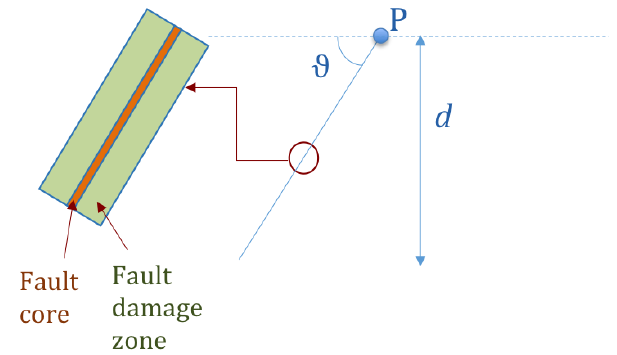
Figure 1. Geometry of a fault. Fault extends from a shallow point P , over a vertical distance d and forms a dip-angle θ with the hori- zontal axis. The fault structure comprises two units: a central narrow core zone surrounded by a wider damage zone. Both units have dif- ferent hydrological and mechanical parameters to the surrounding rock.